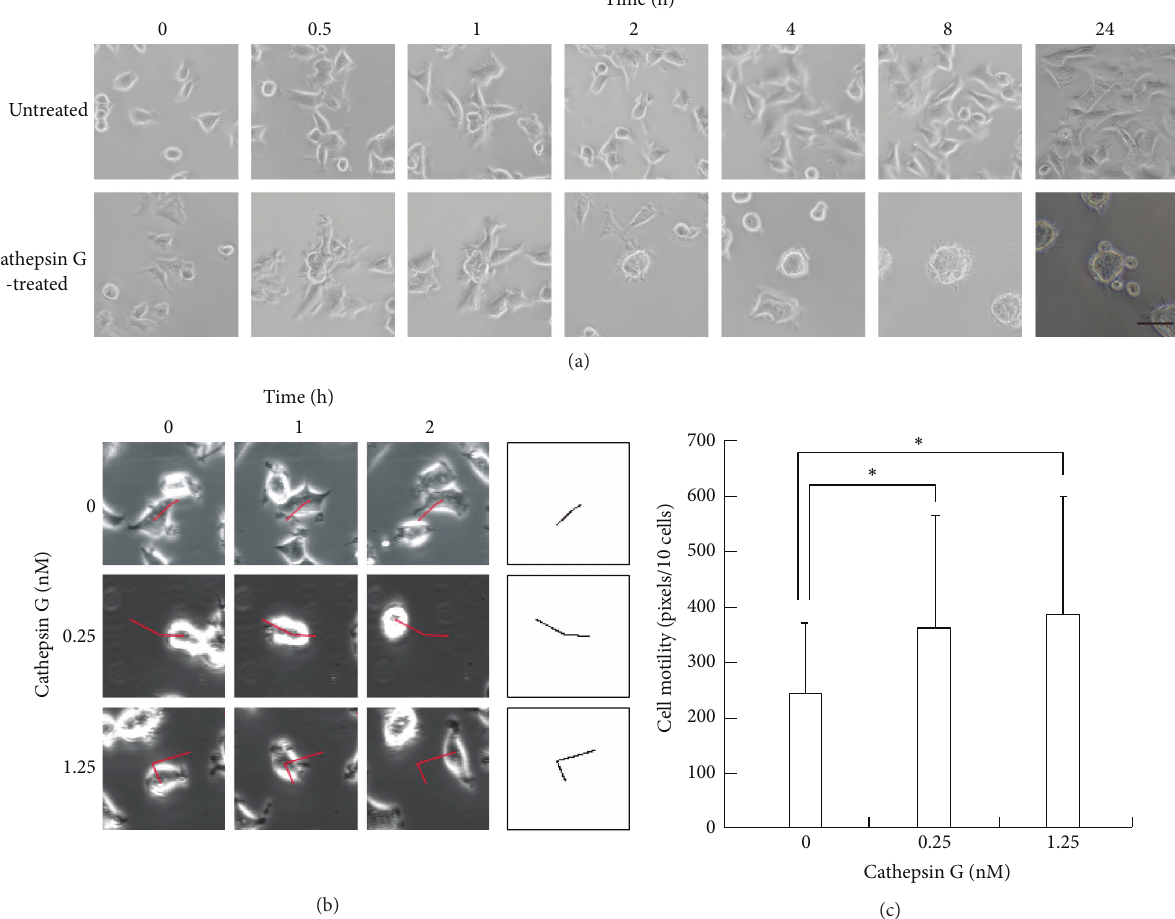
Figure 1: Cathepsin G increases the motility of MCF-7 cells. (a) Time course of the formation of MCF-7 cells aggregates by cathepsin G. MCF-7 cells ( 1 × 10 4 cells/well) were seeded in a 96-multiwell plate in RPMI 1640 medium containing 5% FBS. The cells were cultured for 24 h and then incubated without or with cathepsin G (40nM) in medium containing 1% BSA for the indicated periods. Scale bar = 50 𝜇 m. (b) Quantification of cathepsin G-treated MCF-7 cell motility. The cells were grown on a glass-based dish in RPMI 1640 supplemented with 5% FBS the day before measurements were taken. After changing the medium to RPMI 1640 supplemented with 1% BSA, the cells were chronologically observed using confocal laser microscopy with a built-in CO 2 incubator at 37 ∘ C in a humidified atmosphere of 5% CO 2 in air. The trajectories of the cells are shown (red lines in left panels and black lines in right panels). (c) Cell motility of cathepsin G-treated MCF- 7 cells. The trajectories of the 10 cells that were randomly selected in a visual field were quantified using imaging software ImageJ. The results are shown as means ± SD ( 𝑛 = 5 ). Asterisk indicates that the values are significantly different according to the Student’s t -test ( 𝑃 < 0.05